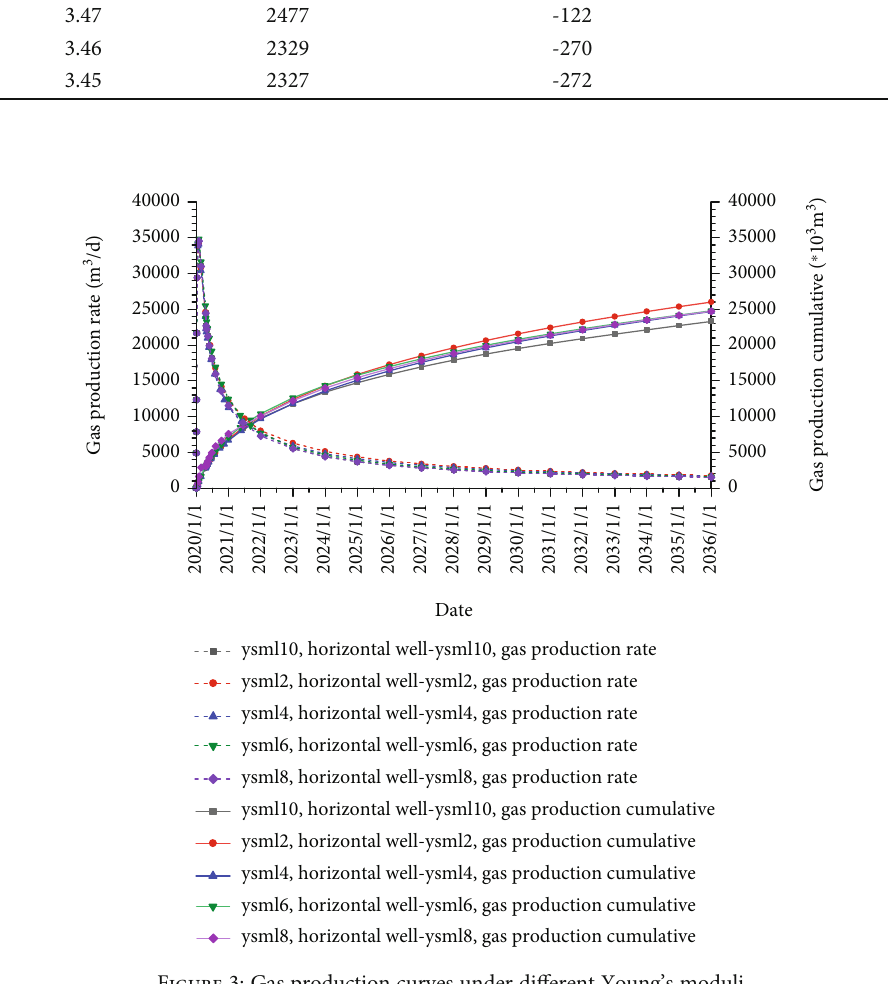
Figure 3: Gas production curves under di ff erent Young ’ s